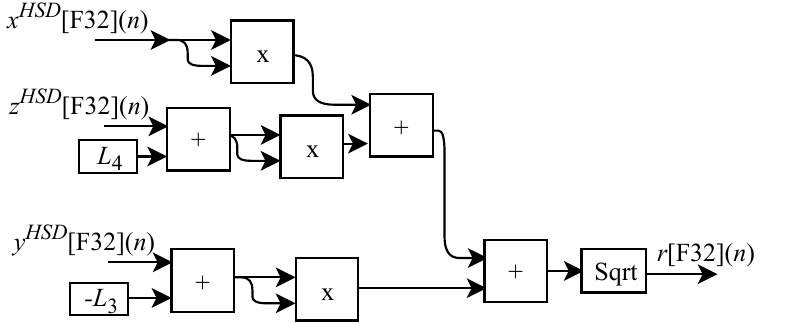
Figure 13. Proposed circuit to perform the calculation of r [ F 32 ]( n ) (Equation